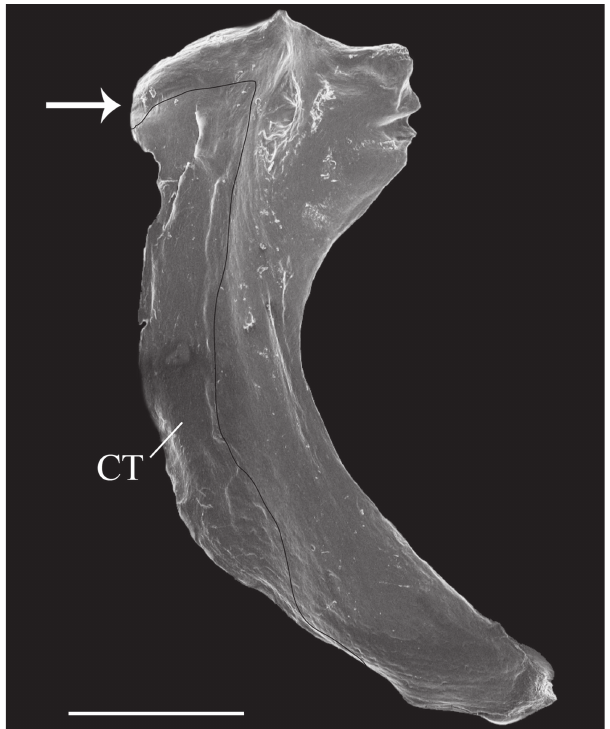
Fig. 5. Scanning electron micrograph of left maxilla (inverted) of Eigenmannia sayona in lateral view, anterior to left (MZUSP 119711, paratype, 116.2 mm LEA). CT= connective tissue on leading edge of maxilla. Arrow indicates the anterodorsal process. Scale bar: 0.5